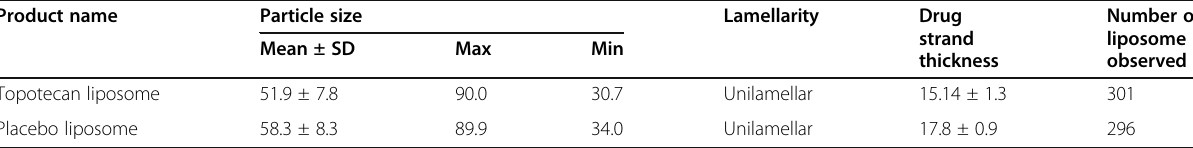
Table 5 Cryo-TEM results for topotecan liposome and placebo liposome